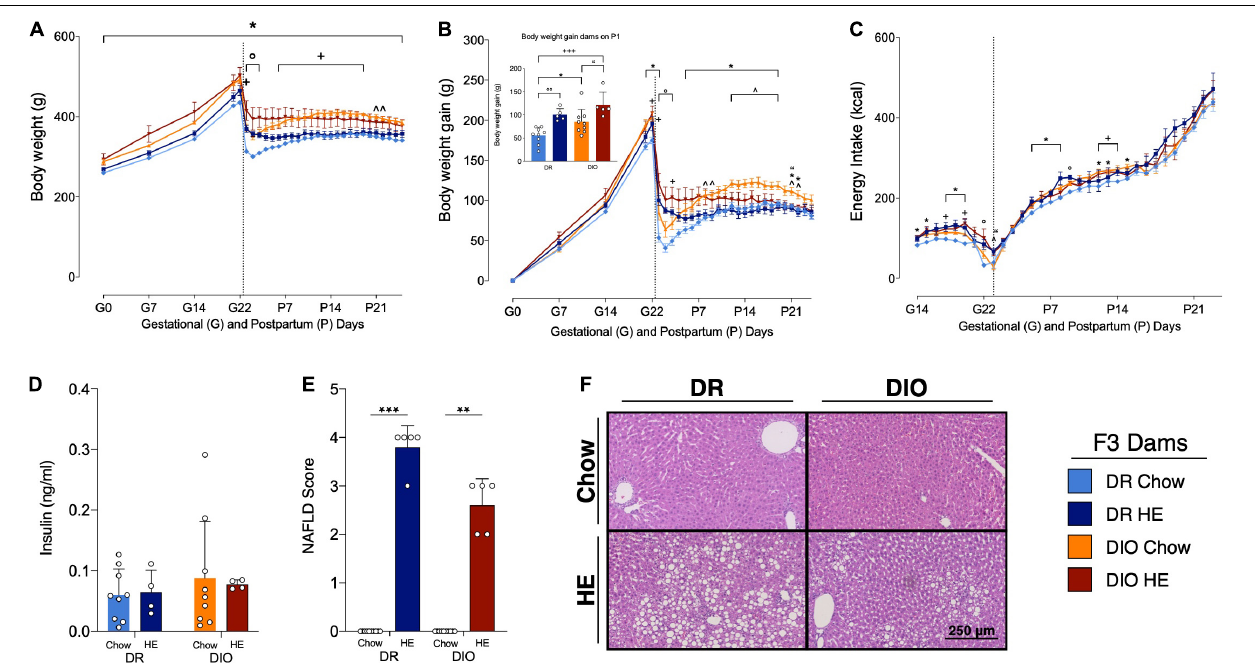
FIGURE 4 | Influence of HE-diet on physiological parameters in diet resistant (DR) and diet induced obese (DIO) rat dams in filial generation 3 (F3) before, during and after pregnancy. Body weight in grams (A) , body weight gain in grams (B) , and energy intake in kilocalories (C) of DR dams on chow (light blue), or HE diet (dark blue), DIO dams on chow (orange), or HE diet (red) during pregnancy and lactation. Vertical dotted line marks parturition. (B) Inset shows body weight gain during pregnancy (difference between body weight on G1 and P1. (D) Insulin levels (ng/ml) in plasma of DR and DIO dams on chow or HE diet at sacrifice on P21 ± 1. (E) Average severity of liver steatosis scores according to the NAFLD scoring system for rodents (Grade 0–4) in DR and DIO dams on chow or HE diet. (F) Representative images of H&E stained liver sections. Data are represented as mean ± SD. In (A–C) , symbols denote significant differences between specific groups: ◦ DR-Chow vs. DR-HE; * DR-Chow vs. DIO-Chow; + DR-Chow vs. DIO-HE; ∧ DR-HE vs. DIO-Chow; “DIO-Chow vs. DIO-HE. For all comparisons, the number of symbols signify level of significance: * P < 0.05, ** P < 0.01, *** P < 0.001. DR-chow ( N = 10), DR-HE ( N = 5), DIO-chow ( N = 9), and DIO-HE ( N =